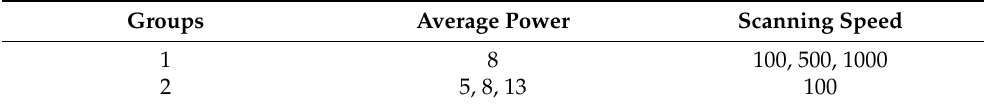
Table 2. Laser processing parameters used for simulations.